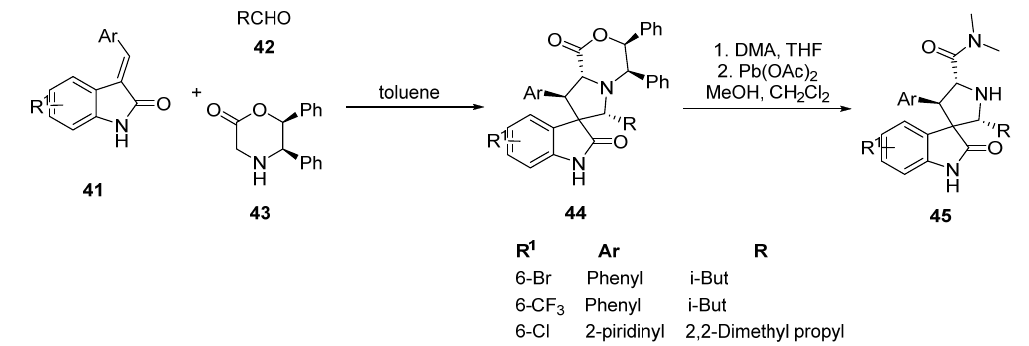
Scheme 6. The general scheme for the synthesis of compounds of the MI series, proposed by a group of researchers from the University of Michigan [38].